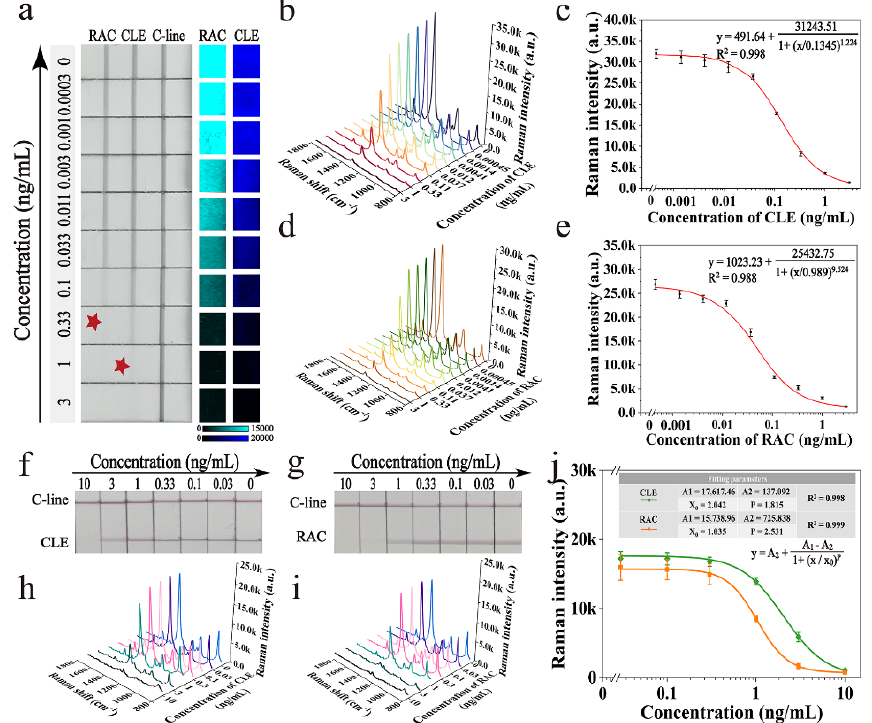
Figure 4. ( a ) Graphs of the test strips based on Mag@Au-ICA detection of different concentrations of CLE and RAC and the corresponding SERS mapping images. ( b , d ) Average SERS spectra of the two test lines and ( c , e ) the corresponding calibration curves. ( f , g ) Results of the test strips with different concentrations of CLE and RAC, ( h , i ) corresponding average SERS spectra, and ( j ) corresponding calibration curves based on AuNP/DTNB-ICA. Table 1. Comparison with other immunochromatographic methods.